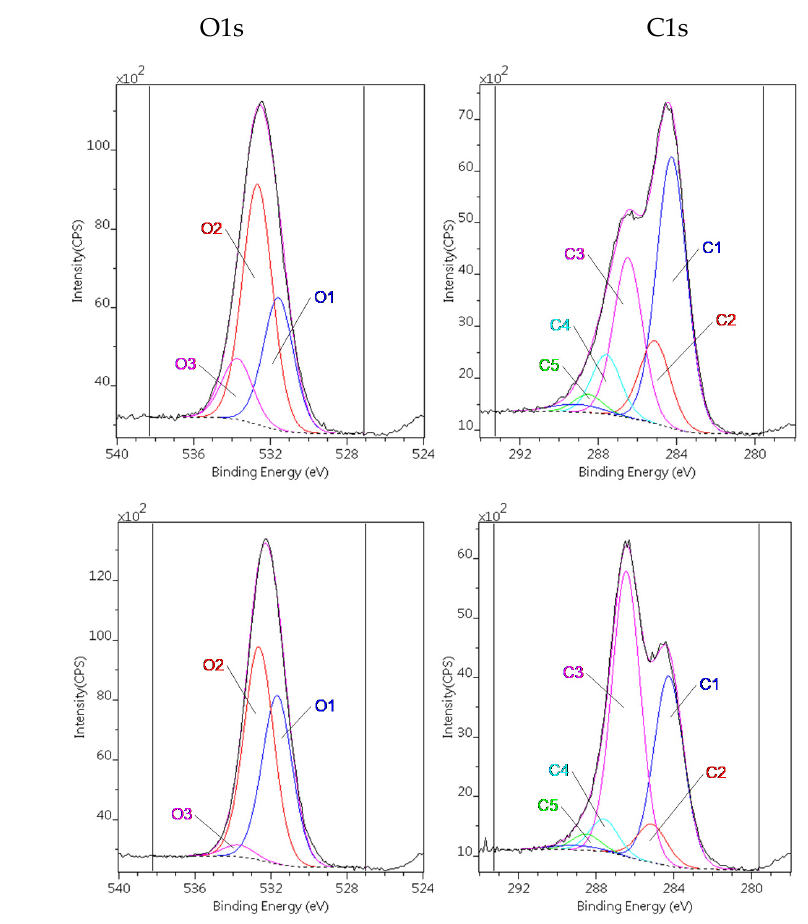
Figure 14. Decomposed O1s and C1s region of the fresh and aged GO samples. (Probes from the “2y” sample were freeze-dried and analysed both when it was fresh and after 2 years.).